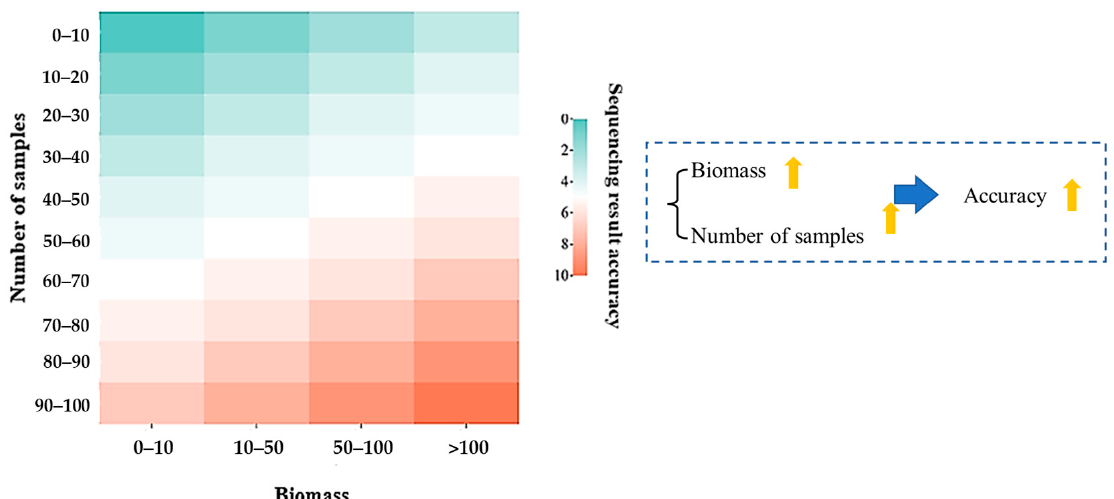
Figure 3 . Heat map of the accuracy of sequencing results. The higher the biomass and the higher the number of samples, the greater the accuracy of sequencing results. Due to the low microbial biomass of cuttings, the accuracy of sequencing results is greatly affected. Therefore, a strict quality control process is required to ensure the accuracy of downstream analysis.